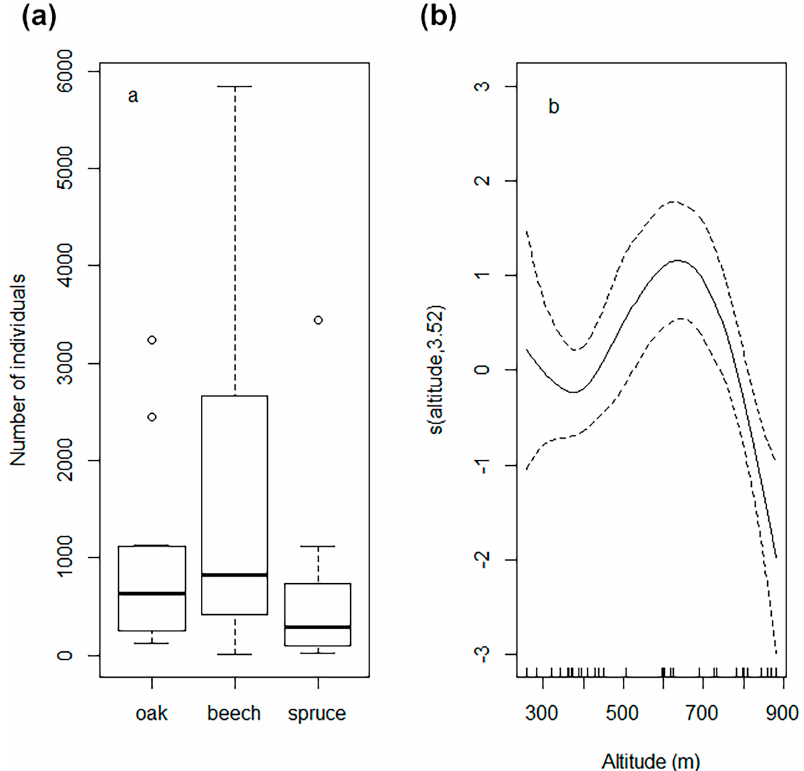
Figure 2. The number of dispersing X. germanus females caught in ethanol-baited flight interception traps ( n = 36) set in the Kremnické vrchy Mountains, West Carpathians, Slovakia, during the whole dispersal period of the beetle in 2016. Plastic bottle traps were baited with 100 ml of 85% absolute ethanol and replaced at one-week intervals. (a) Boxplots (median, IQR, minimum and maximum, outlying values as open circles) of the number of X. germanus for oak, beech and spruce forest stands as categorical explanatory variables. (b) Estimated smoothing curves for the NB GAM model containing altitude as a solo explanatory variable; the solid line is the smoother, dotted lines are the 95% point-wise confidence intervals, 3.52 is the effective degrees of freedom, and the vertical lines along the x-axis are the altitude values of the observations. Statistical data analyses and graphics were performed in R [76].